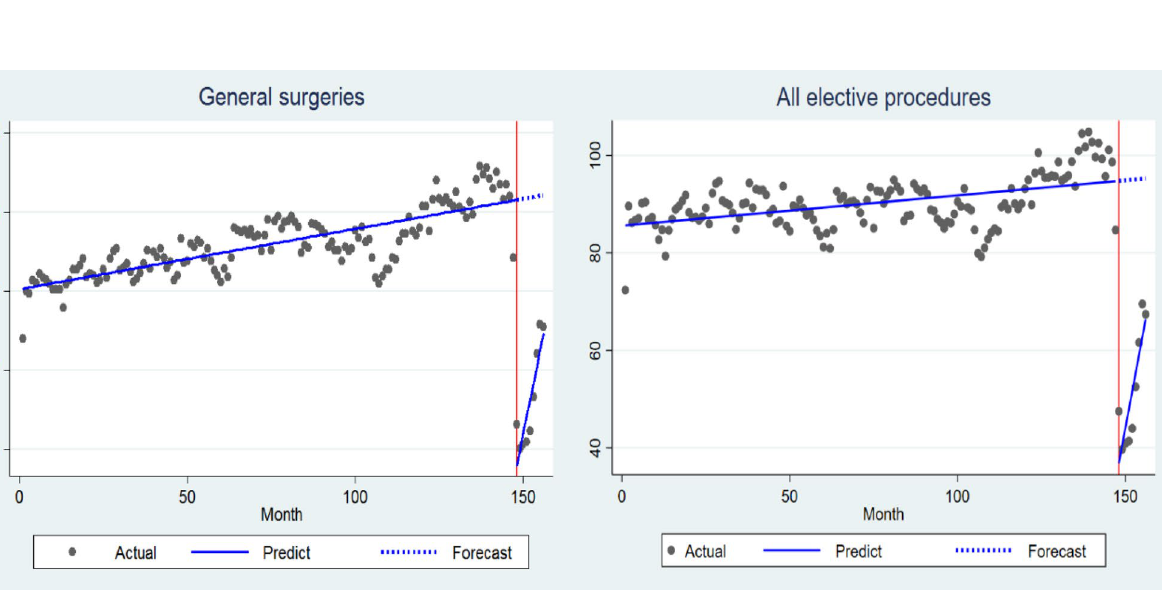
Table 2. Results from the interrupted times series approach for hospitalization rate for elective procedures (general surgeries and all elective procedures) in Brazil, January 2008 to December 2020. Confidence intervals in Parentheses. All elective procedures include general surgeries.